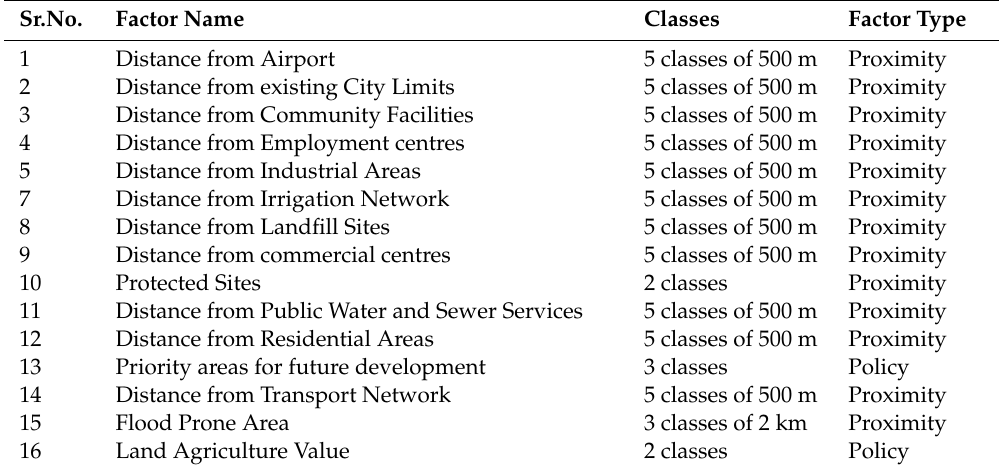
Table 3. List of factor layers and associated classes to be